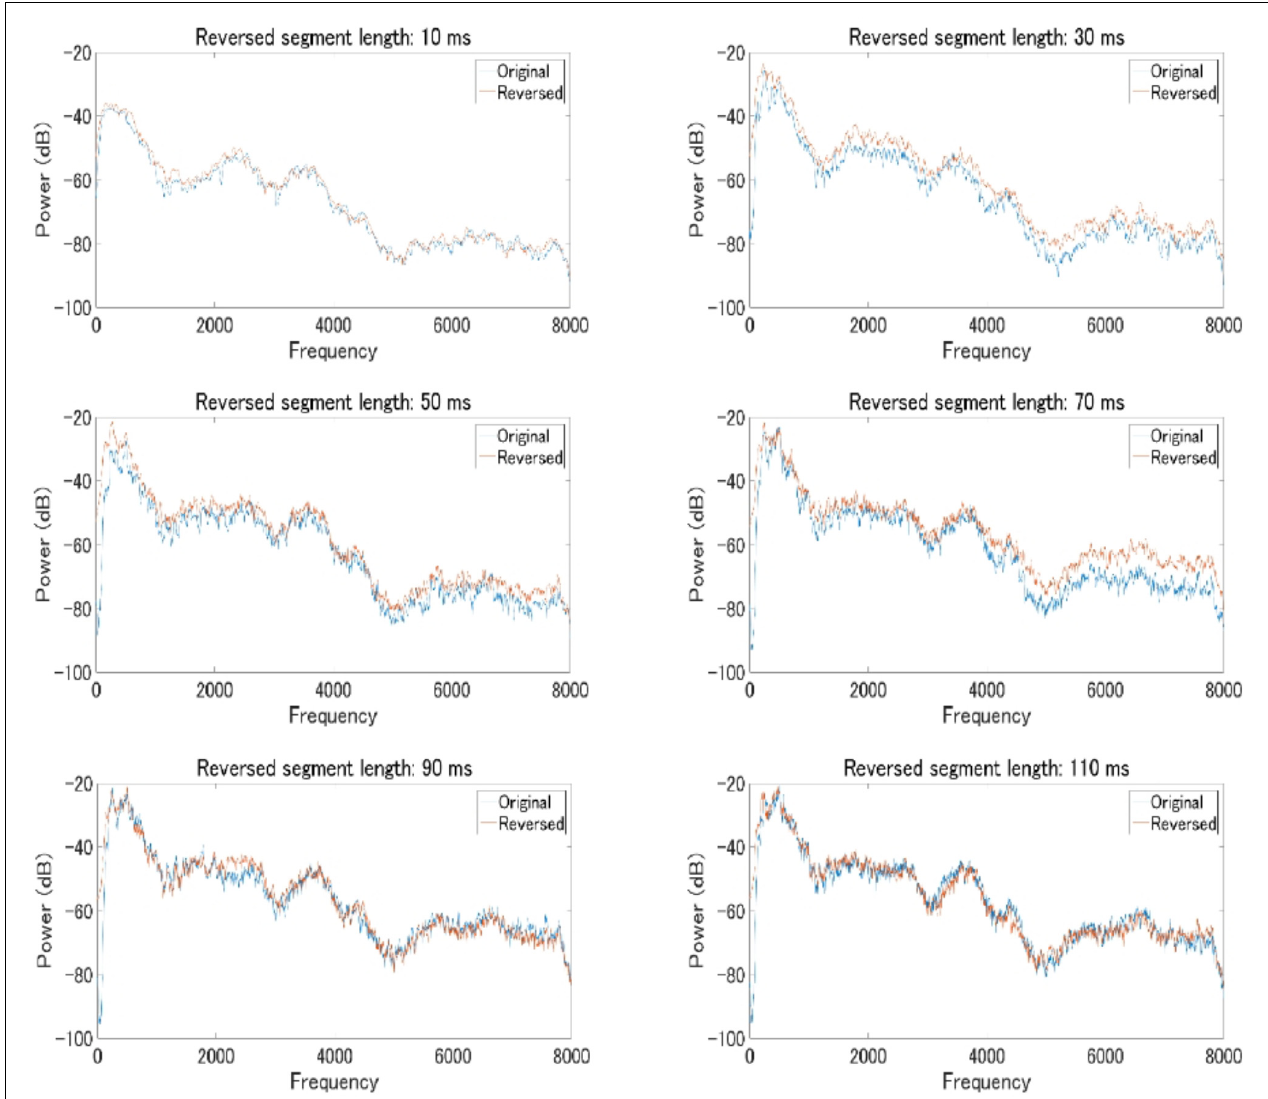
FIGURE 6 | The average power spectrum of 18 original sentences (blue line) and 18 locally time-reversed sentences (red line) across all frequency range, according to the reversed segment length of 10 ms (top left) , 30 ms (top right) , 50 ms (middle left) , 70 ms (middle right) , 90 ms (bottom left) , and 110 ms (bottom right) . The horizontal axis shows frequency range (0–8,000 Hz), and the vertical axis shows power range (–20 to –100